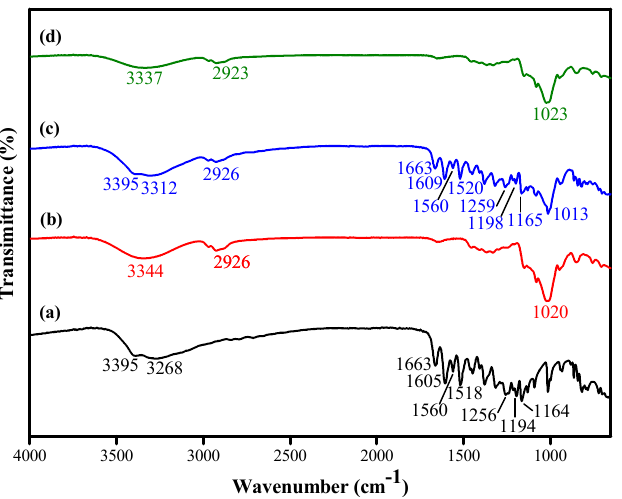
Figure 1. FTIR spectra of ( a ) quercetin, ( b ) HP- β -CD, ( c ) quercetin/HP- β -CD physical mixture, and ( d ) quercetin/HP- β -CD inclusion complex.